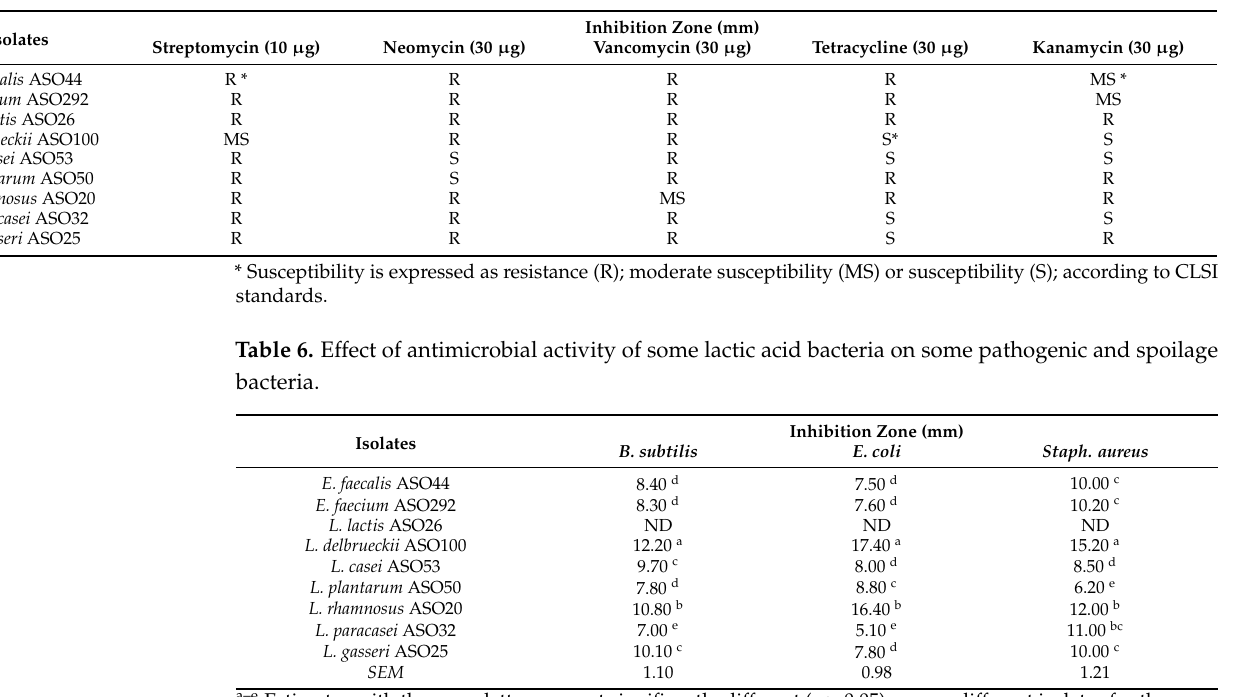
Figure 4. Percentage of bile tolerance of the isolated lactic acid bacteria during different incubation times of 0, 1, 2, 3, and 4 h. LAB isolates were grown on 0.5% ox-bile salt for 4 h, and percentages of tolerance were estimated by counting viable bacterial counts which tolerated the bile salt with relative to untreated controls (with no bile salts). a–i Estimates with the same letters are not significantly different ( p > 0.05) among different isolates for the same incubation time. Table 5. Antibiotic resistance of isolated lactic acid bacteria.